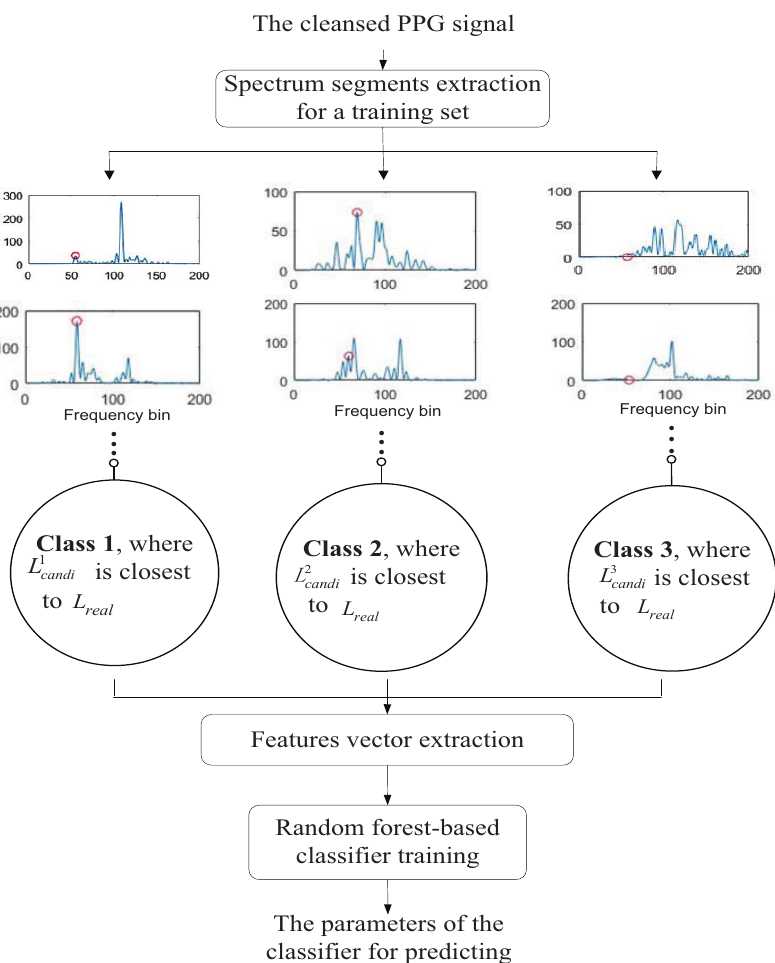
Figure 3. The training process of the random forest-based classifier in Stage